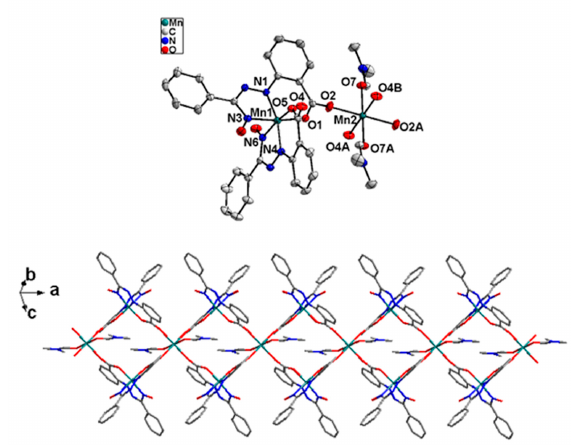
Figure 2. Molecular structure of complex 2. Top: thermal ellipsoids. Bottom: The 1D chain structure. Hydrogen atoms and solvent molecules are omitted for clarity. Mn: cyan; C: gray; N: blue; O: red. Table 3. Bond length (Å) and angles ( ◦ ) of the Mn(II) ions in complexes 1–2. 1